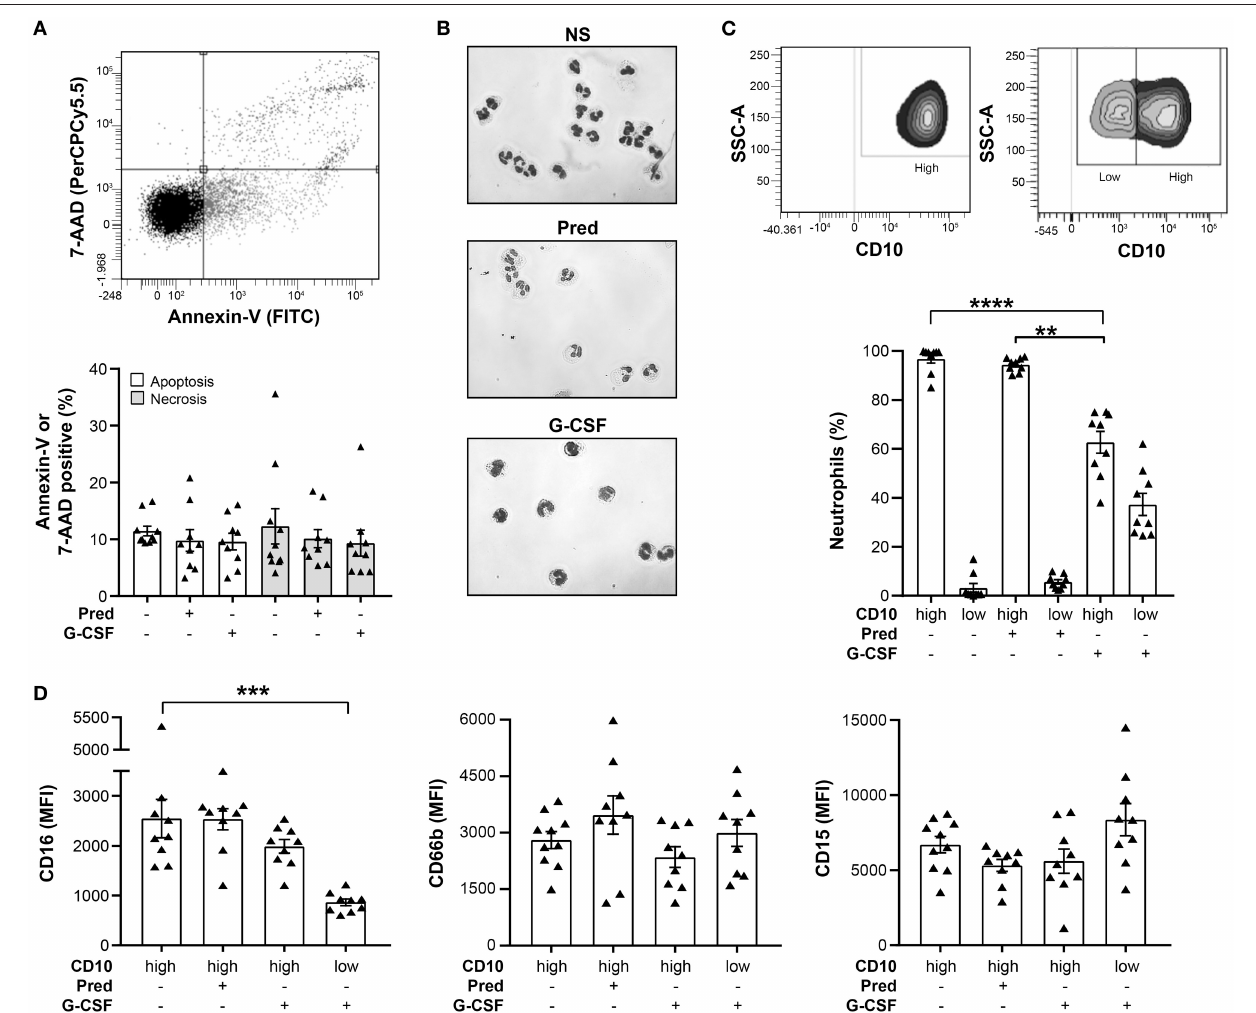
FIGURE 2 | Viability, morphology, and cell-surface marker expression of prednisone- and G-CSF-mobilized neutrophils. (A) The proportion of neutrophil, spontaneous apoptosis and necrosis was determined by 7-AAD/Annexin-V staining in prednisone and G-CSF GCs as well as neutrophils of non-stimulated, healthy donors. A representative two-dimensional plot of Annexin-V/7-AAD staining is shown above the graph. (B) Nuclear morphology of neutrophils from control, non-stimulated-donors (NS) (top) , prednisone- (middle) and G-CSF-mobilized neutrophils (bottom) after Pappenheim staining. (C) Proportion of circulating neutrophils that display high or low CD10 cell-surface expression determined by flow cytometry. A representative plot of CD10 staining in a CD10 high (left) and a CD10 high /CD10 low (right) sample is shown above the graph. (D) Cell-surface expression of CD16 (left) , CD66b (middle) and CD15 (right) determined by flow cytometry and expressed as mean fluorescence intensity (MFI) . Statistical analysis: Dunn’s multiple comparison test was performed to compare cell-surface marker expression between prednisone- and G-CSF-mobilized neutrophils, ** p -value < 0.01; *** p -value < 0.001; **** p -value < 0.0001. These data are compiled from the analysis of 9 prednisone and 9 G-CSF GCs as well as neutrophils of 10 non-stimulated healthy